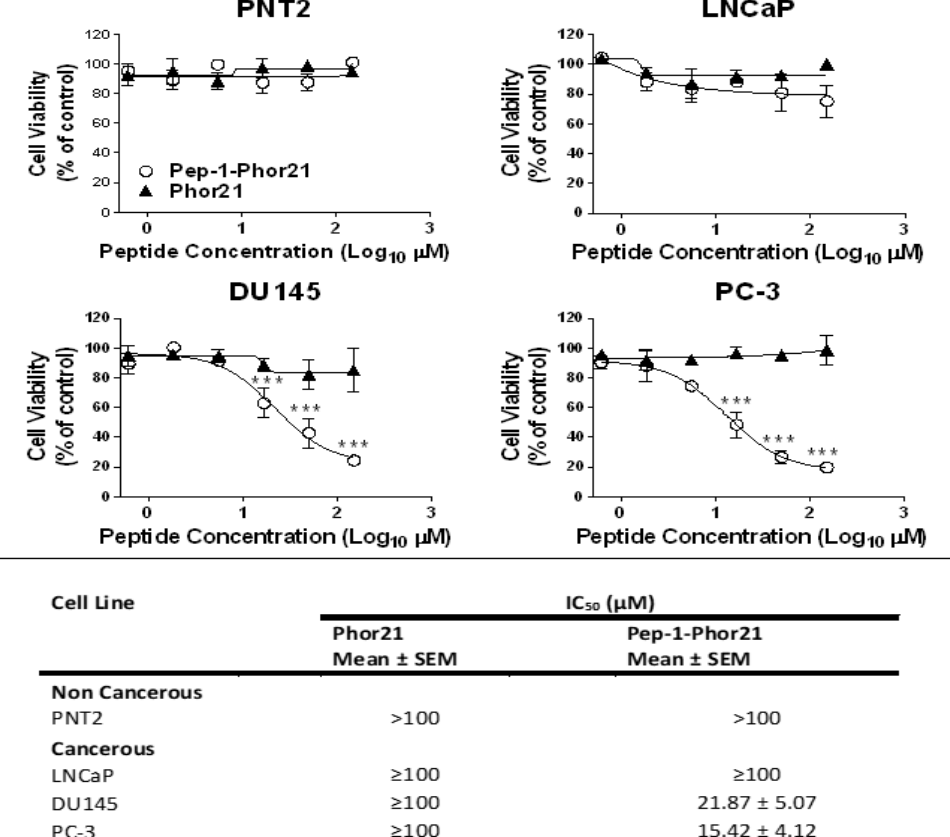
Figure 8. Dose-dependent effect of Pep-1-Phor21 on the viability of 3D-cultured prostate cancer cells assessed using CellTox green assay. Dose-dependent effect of Pep-1-Phor21 and Phor21 on the viability of non-IL-13R α 2-expressing cell lines (PNT2 and LNCaP) and IL-13R α 2-expressing cell lines (DU145 and PC-3). The cells were treated with 0–150 µM of Pep-1-Phor21 or Phor21 peptides for 3 h and the viability of cells was assessed using the CellTox assay. The data represent means ± SEM (error bars represent SEM) of three independent experiments (*** p < 0.001).